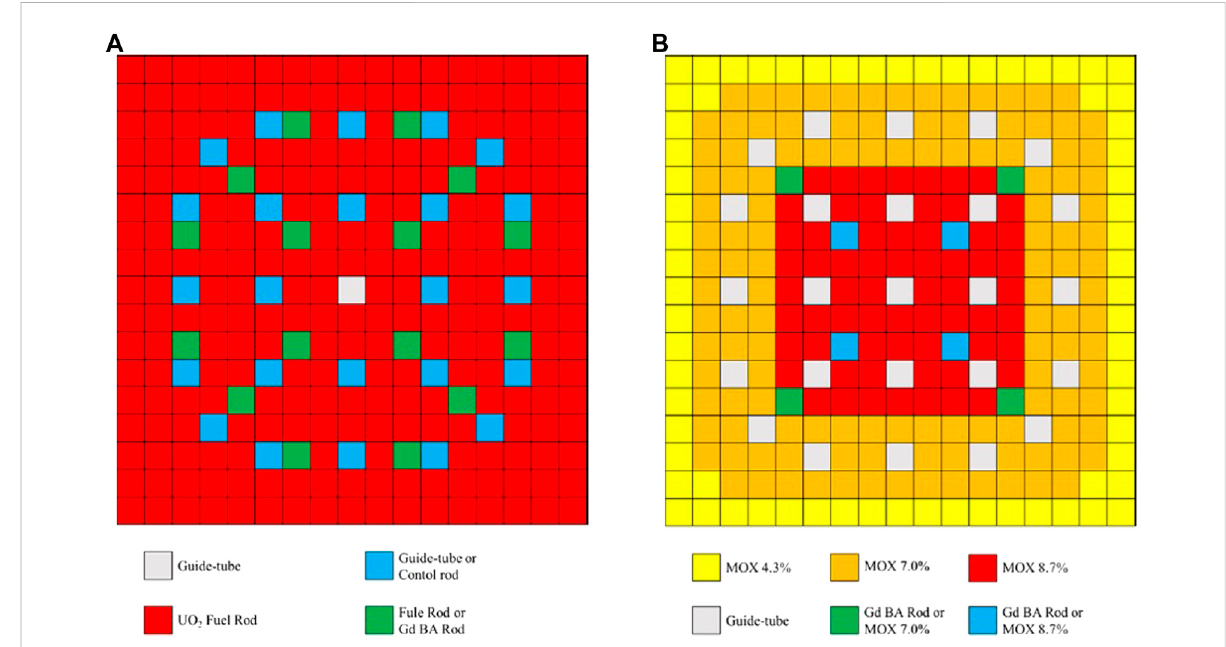
FIGURE 3 Fuel assembly con fi guration of the KAIST-3A benchmark problem: (A) UOX fuel assembly and (B) MOX fuel assembly.